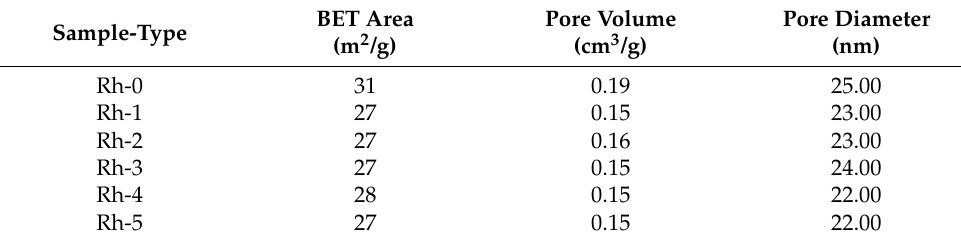
Table 1. Textural aspects of the